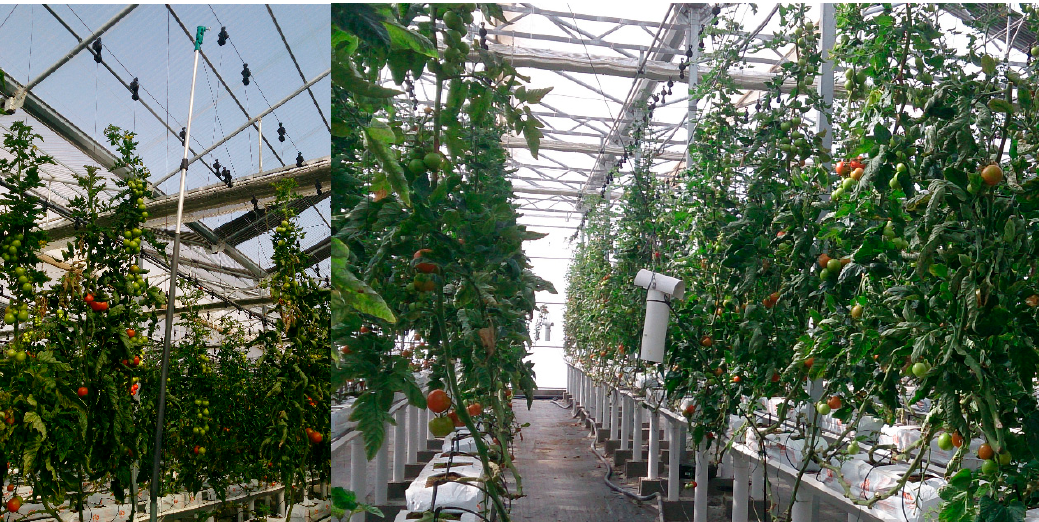
Figure 6. Detail of installation of radiation (left) and temperature (right) sensors.